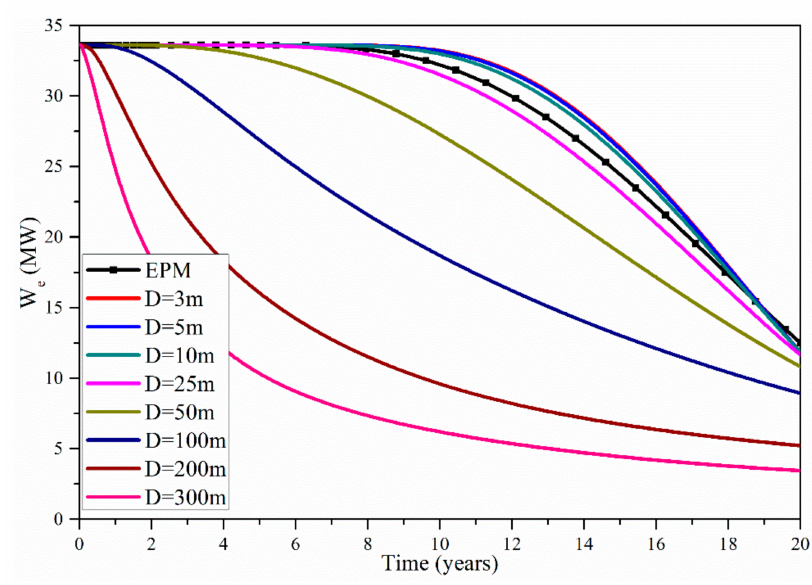
Figure 5. Evolution of the electric power of the EPM method and the MINC